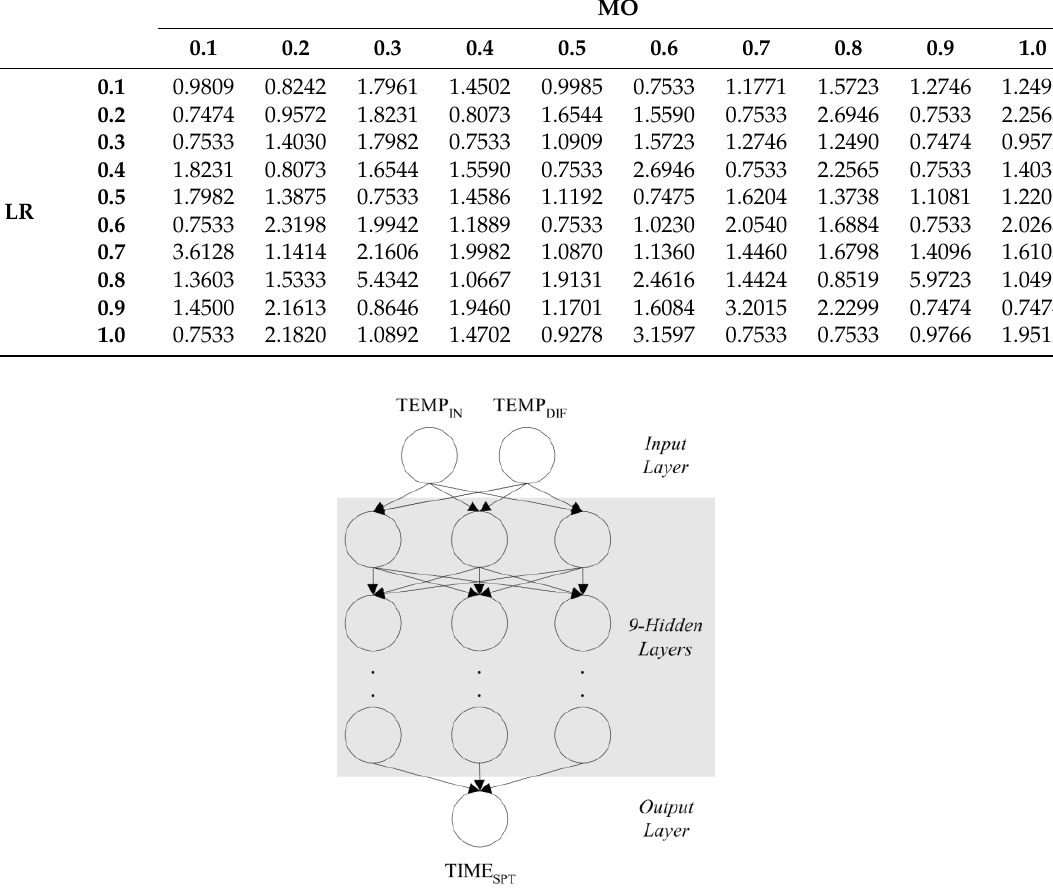
Figure 11. Number of cases according to the amount of difference.